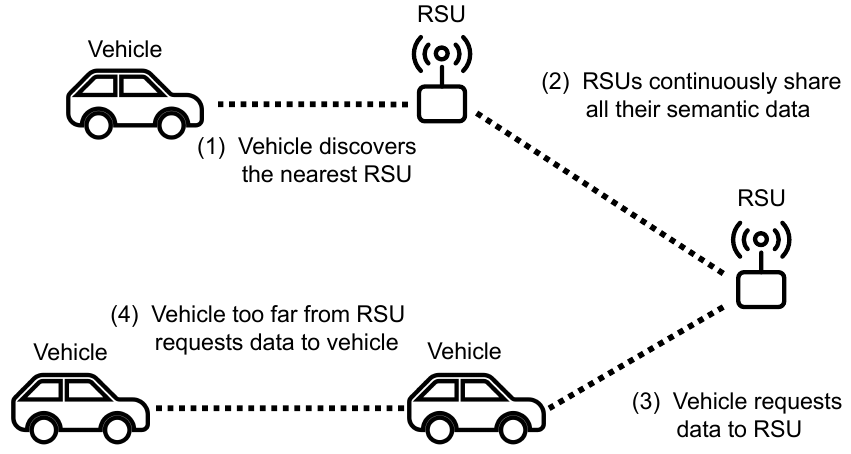
Figure 6. Graphic summary of the four different usage